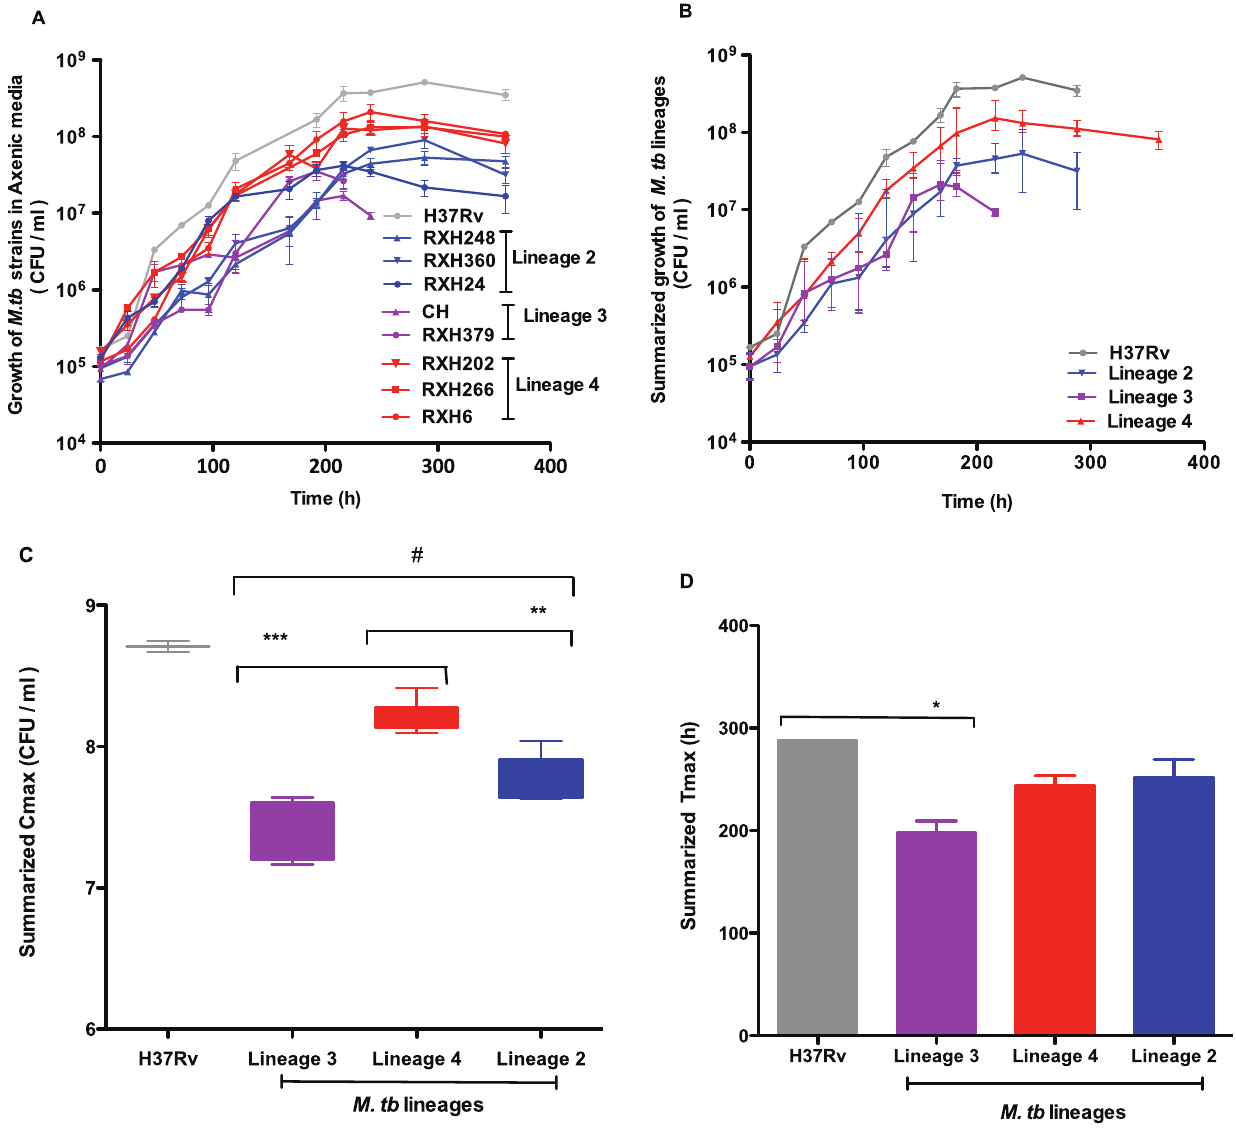
Figure 1. Growth of M.tuberculosis strains in liquid 7H9 broth. Fig. 1 (A) Growth of individual M. tuberculosis strains from different lineages in liquid 7H9 broth. Data represent the mean and range (n=2) values. Fig. 1 (B) Summarized growth of M. tuberculosis strain lineages. Fig. 1 (C) Comparison of C max (maximum point on the growth curve) for different strain lineages. Lineage 4 strains showed higher C max than lineage 2**(p=0.01) and lineage 3*** strains (p=0.001). H37Rv showed significantly higher C max than all clinical strains # (p=0.001) Fig. 1 (D) Comparison of T max (time to reach to C max ) for different strain lineages. H37Rv reached T max significantly faster than lineage 3 strains* (p=0.05).